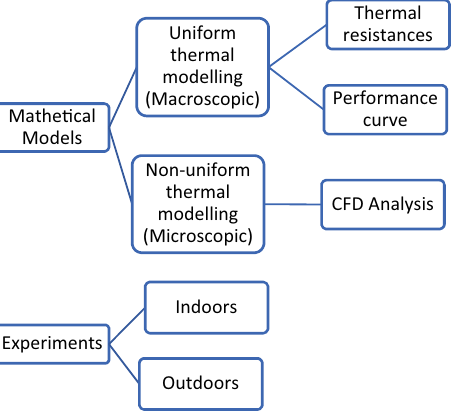
Figure 27: Classi fi cation of thermal